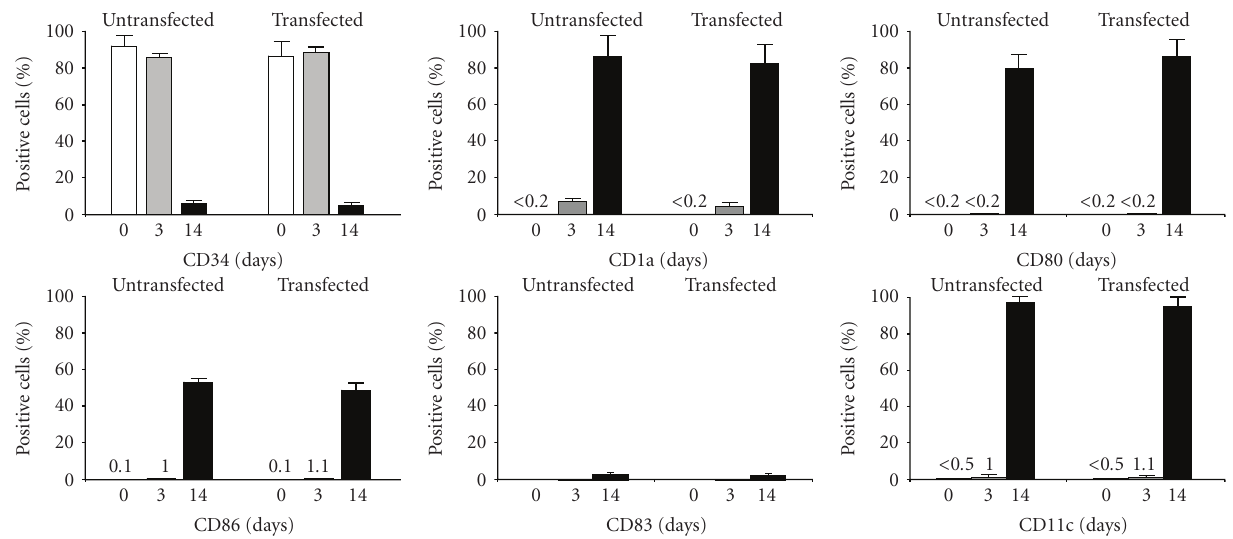
Figure 3: Expression of phenotypic markers throughout HSC di ff erentiation into immunogenic dendritic cells in presence of multiple, DOTAP- mediated transfection rounds . HSCs were subjected to di ff erentiation agents, and then immediately split into two parallel cultures, one of which was maintained in the absence of manipulations, while the other was subjected to DOTAP-based, scrambled siRNA transfection rounds. Phenotypic antigens typically modulated during HSC di ff erentiation into immunogenic dendritic cells were analyzed in HSCs at day 0 ( white bars ), day 3 ( grey bars ), and day 14 ( black bars ). In all instances, analyses were performed through a FACScan flow cytometer using monoclonal antibodies labeled with fluorescein isothiocyanate or phycoerythrin. Data shown are representative of triplicate determinations.